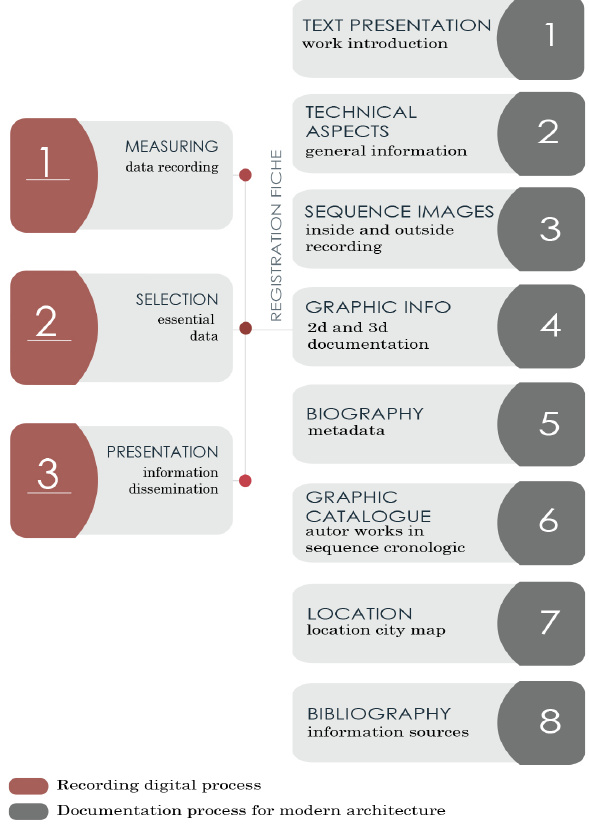
Figure 3: Heritage documentation methodology developed for the identification of local modern architecture in